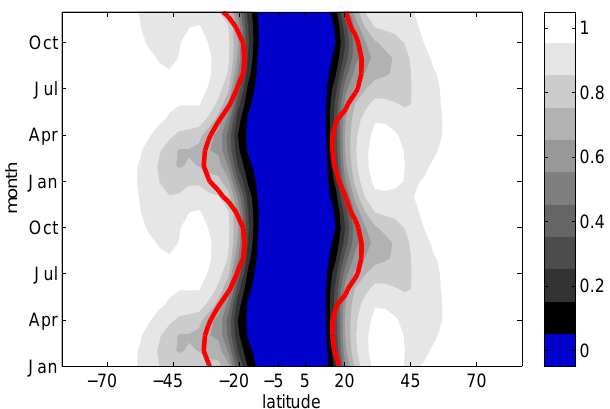
Fig. 6. Simulation with low bare sea-ice albedo and 209ppm CO 2 , which results in 70 % sea-ice cover. Annual cycle of zonal-mean sea-ice fraction. Blue indicates open ocean, white a sea-ice fraction of one (see color bar). Poleward of the red line, sea ice is snow-covered and hence highly reflective. Equatorward of the red line, sea ice is bare and hence comparably dark.